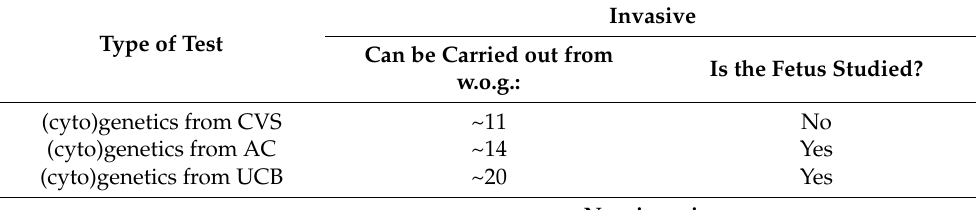
Table 1. Overview on the presently available invasive and non-invasive prenatal diagnostic tests.